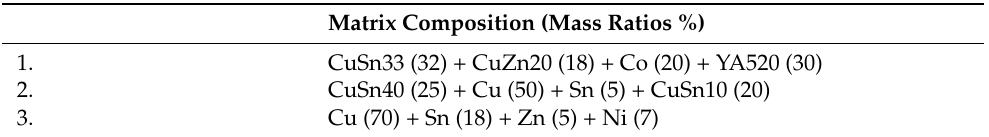
Table 1. Components of three dicing blades [15].